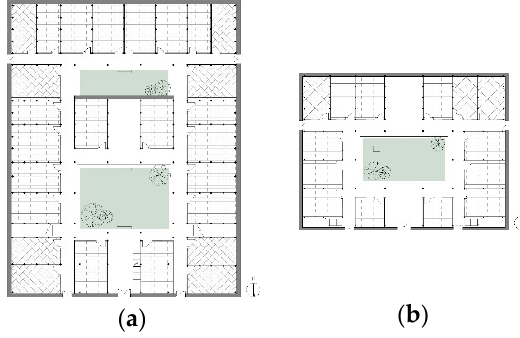
Figure 5. Floor plans of typical dwellings in ( a ) Heyang and ( b ) Danzhi.